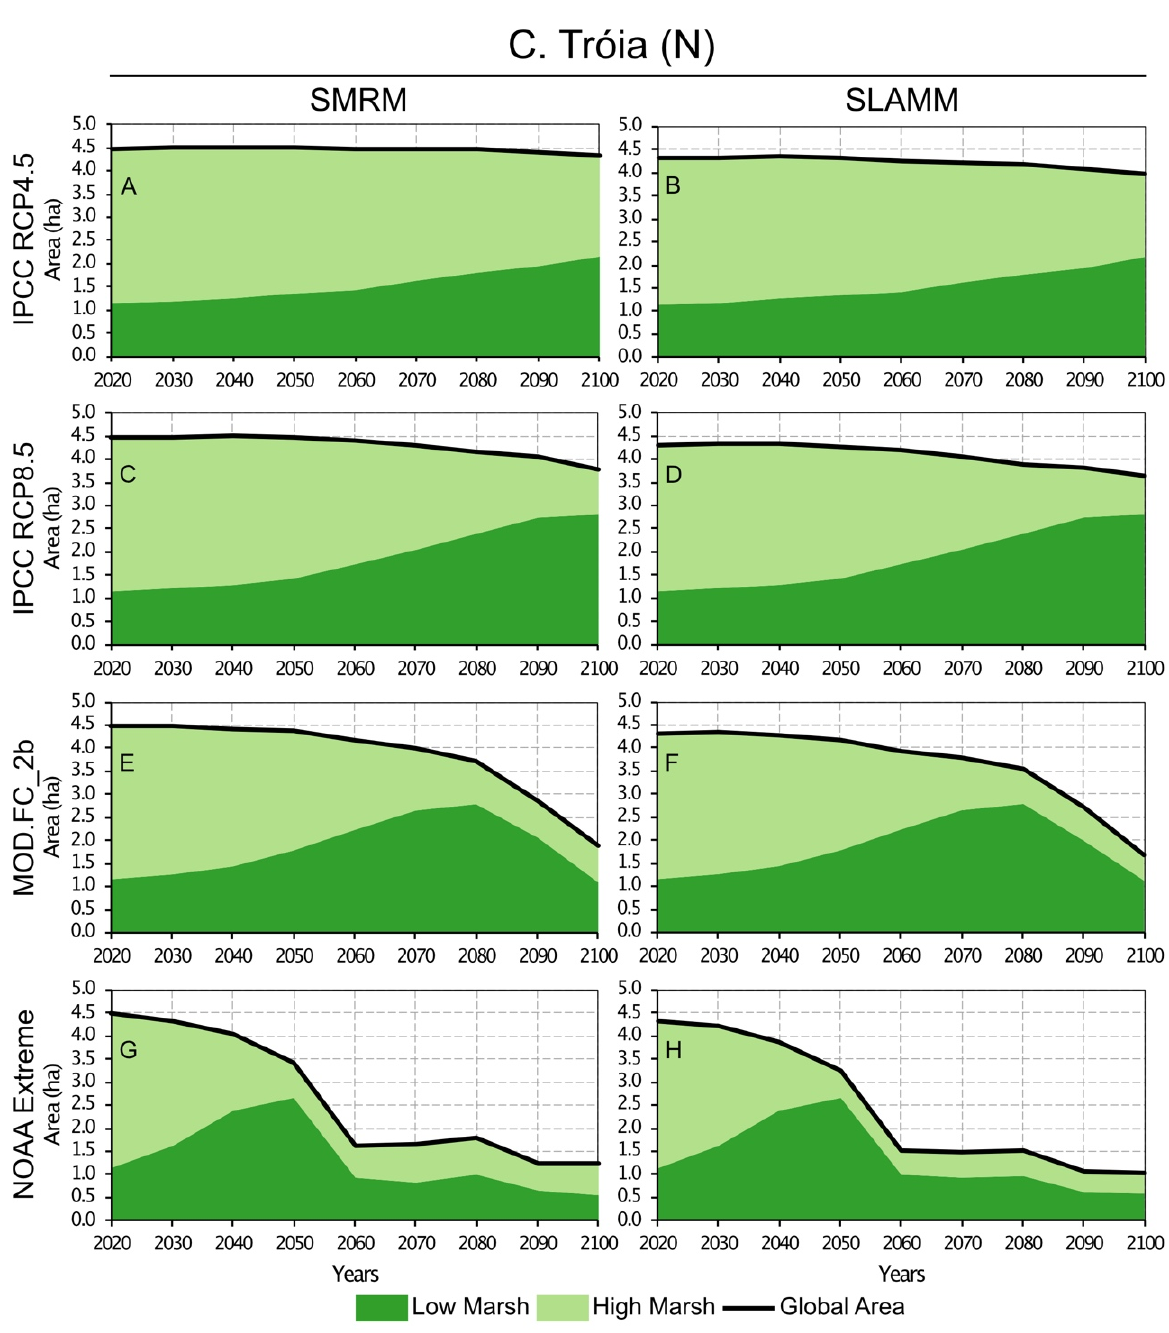
Figure 6. C. Tróia (N) decadal area evolution until 2100, using SMRM and SLAMM, respectively, considering IPCC RCP4.5 ( A , B ), IPCC RCP8.5 ( C , D ), MOD.FC_2b ( E , F ), and NOAA Extreme ( G , H ).